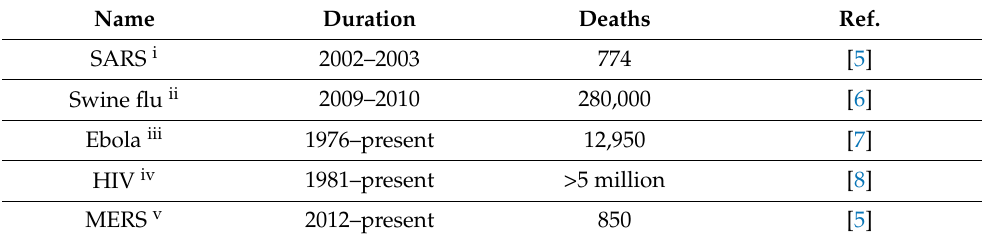
Table 1. List of the most important viral diseases observed in the last fifty years.